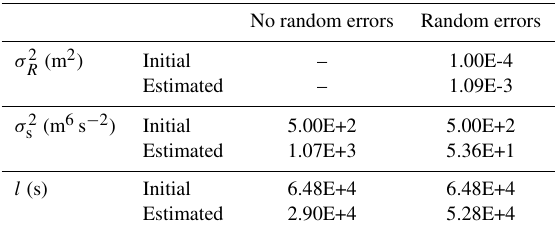
Table 1. Parma River: initial and estimated structural parameters and epistemic error variance.